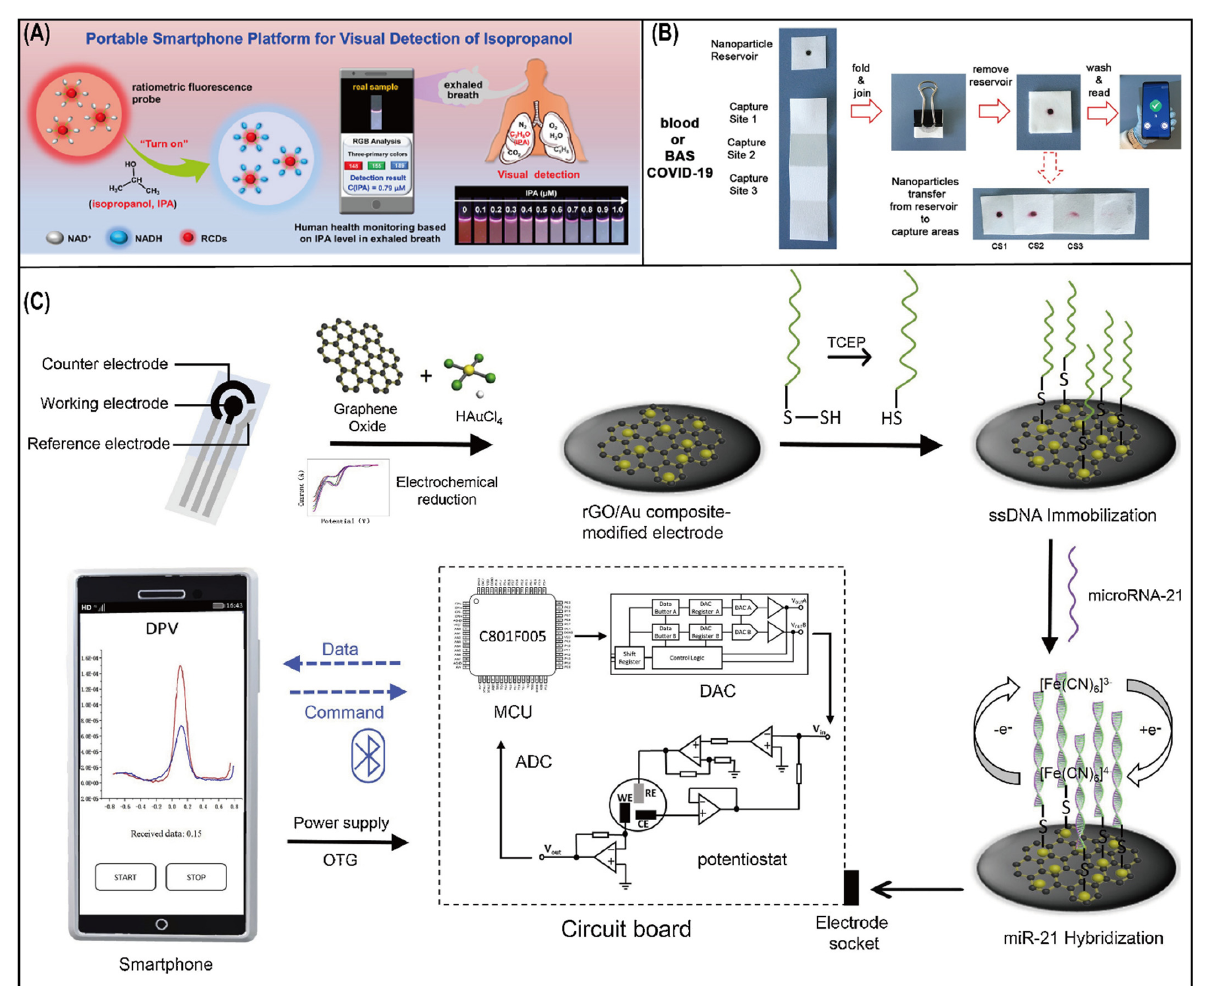
Figure 4. Schematic diagram for detection of IPA, IL-6, and microRNA using a smartphone. ( A ) Schematic diagram of the ratiometric fluorescence sensing system for IPA detection and RGB analysis of the fluorescent photo captured by the smartphone. ( B ) Diagrammatic representation of the paper immunosensor and analytical steps for detecting IL-6 in blood or respiratory samples (bronchial aspirate (BAS)) from COVID-19 patients. ( C ) Illustration of smartphone-based electrochemical biosensing system, including reduced graphene oxide/gold composite-modified electrode, circuit board, and smartphone with Android application.